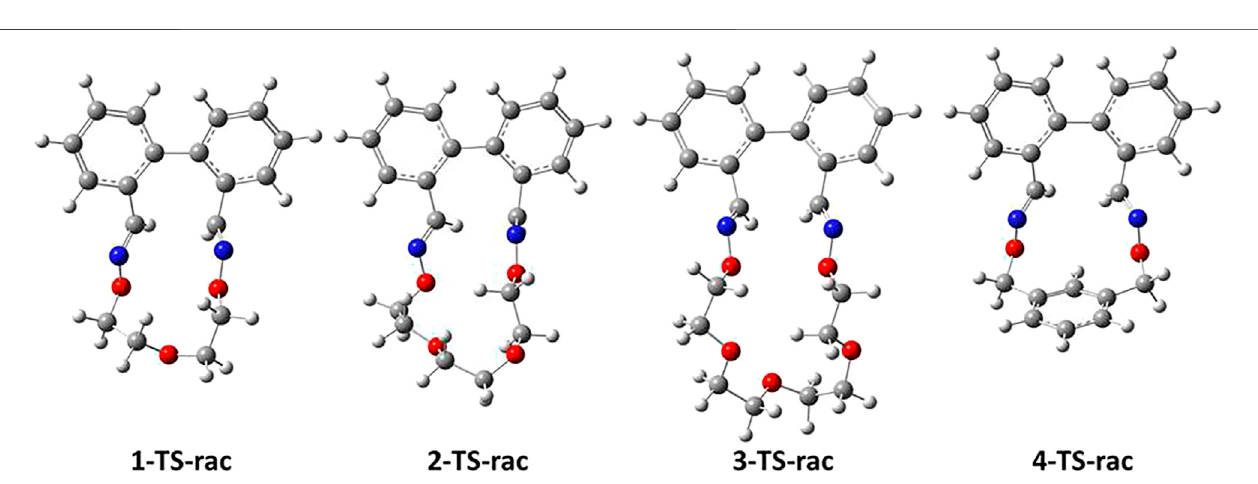
FIGURE5| TSgeometriescorrespondingtotheracemizationprocessesofmacrocycles1 – 4.CalculationswerecarriedoutoptimizedatthePBE0-D3/Def2-TZVP level of theory.